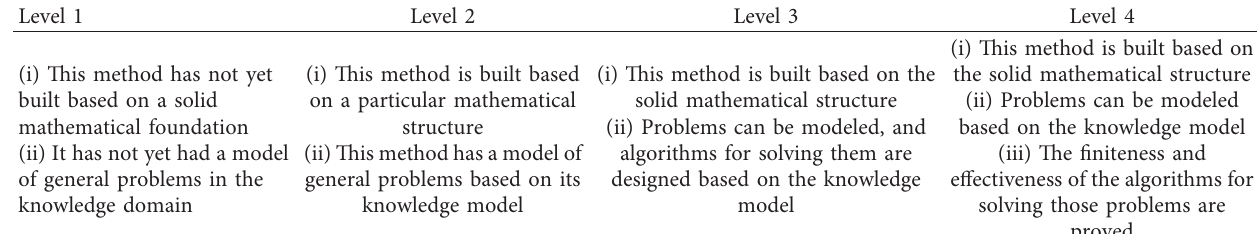
Table 5: Levels of the formality criterion.